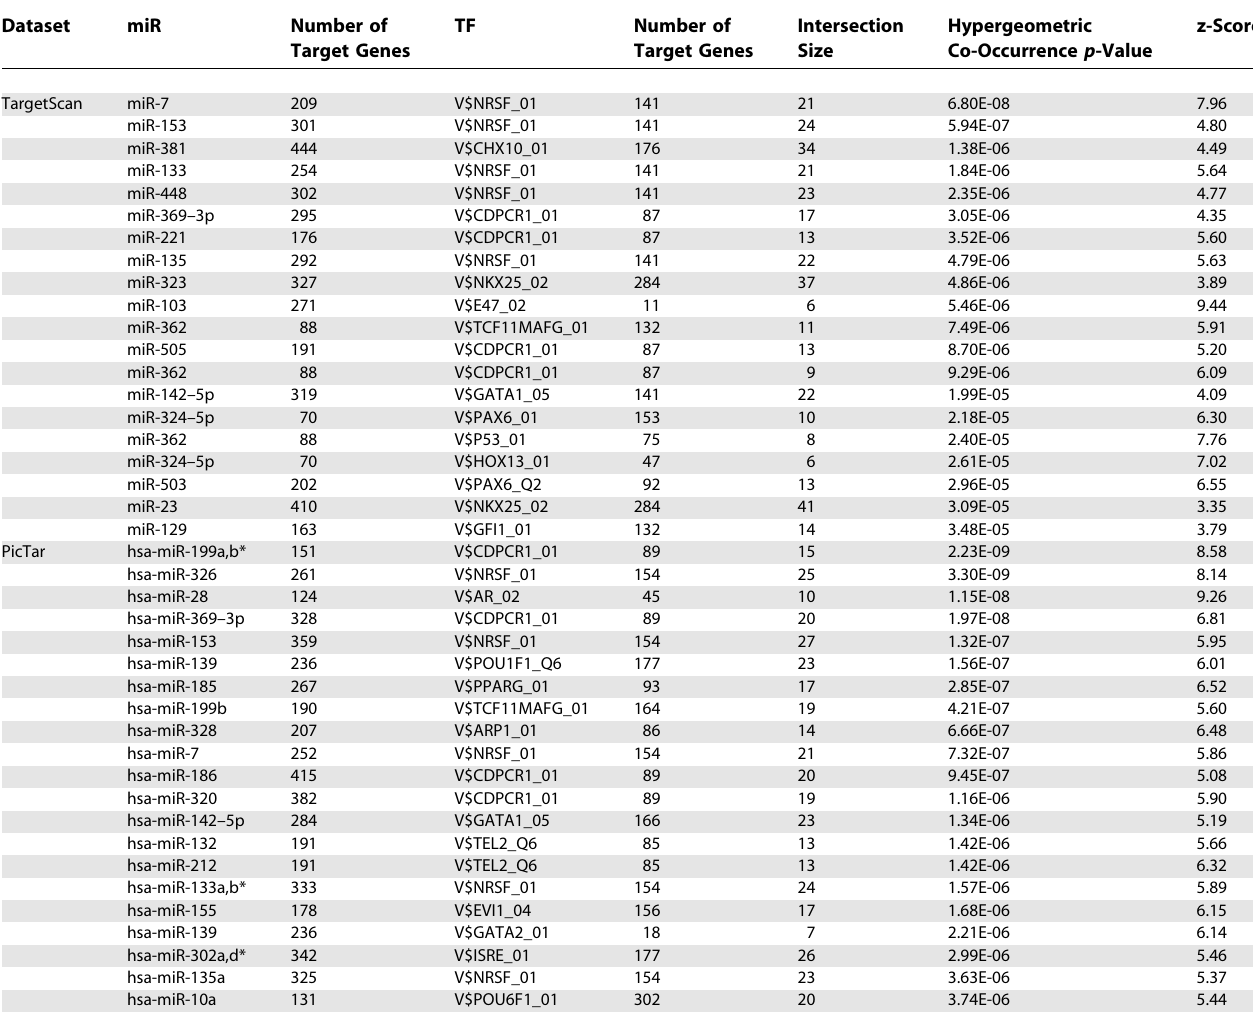
Table 3. Top 20 Most Significant Pairs of Coregulating miRNAs and TFs in the TargetScan and PicTar Networks Dataset